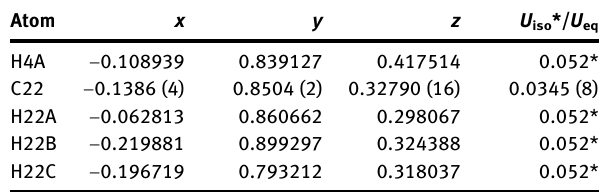
Table  : Fractional atomic coordinates and isotropic or equivalent isotropic displacement parameters (Å 